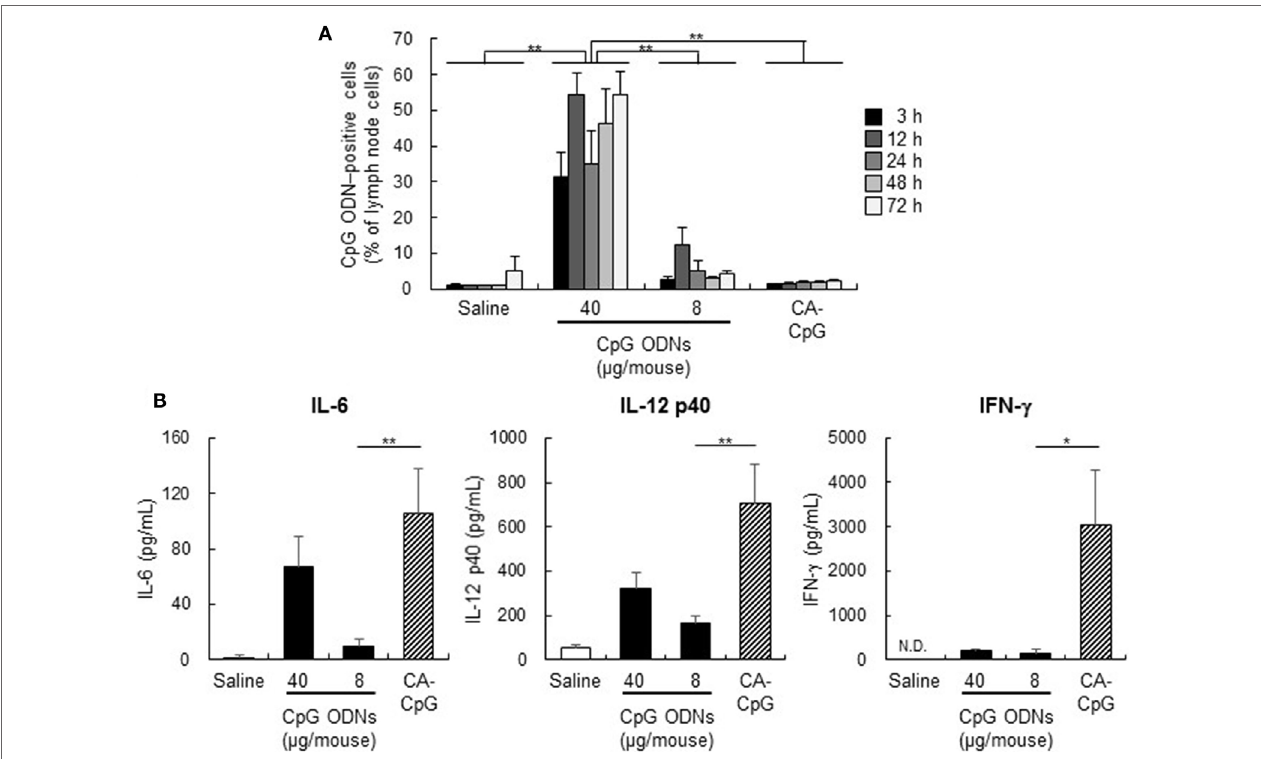
FigUre 4 | Biodistribution of carbonate apatite (CA)-cytosine-phosphate-guanine (CpG) in vivo and cytokine production induced by CA-CpG in draining lymph nodes. (a) Biodistribution of CA-CpG in vivo . Mice were treated with CA-Alexa 488-CpG or Alexa 488-labeled K-type CpG oligodeoxynucleotides (ODNs) into the ear pinna, and internalization of K-type CpG ODNs by cells in draining lymph nodes was measured by flow cytometry at the indicated time points after trypan blue quenching. Treatment with CA-CpG did not increase the number of cells that internalized CpG ODNs, n = 5 per group. (B) Cytokine production induced by CA-CpG in draining lymph nodes. CA-CpG (8 µg CpG ODNs/mouse) or K-type CpG ODNs (8 or 40 µg CpG ODNs/mouse) were administered into the ear pinna. After 24 h, lymph node cells in draining lymph nodes were harvested and cultured for 8 h, and the levels of IL-6, IL-12 p40 and IFN- γ in the culture supernatants were evaluated. CA-CpG induced higher levels of cytokine production than did K-type CpG ODNs, n = 5 per group. Data are given as mean ± SEM. * p < 0.05, ** p < 0.01 as indicated by Tukey’s test (a) or vs. K-type CpG ODNs (8 µg CpG ODNs/mouse)-treated group as indicated by Dunnett’s test (B) . ND, not